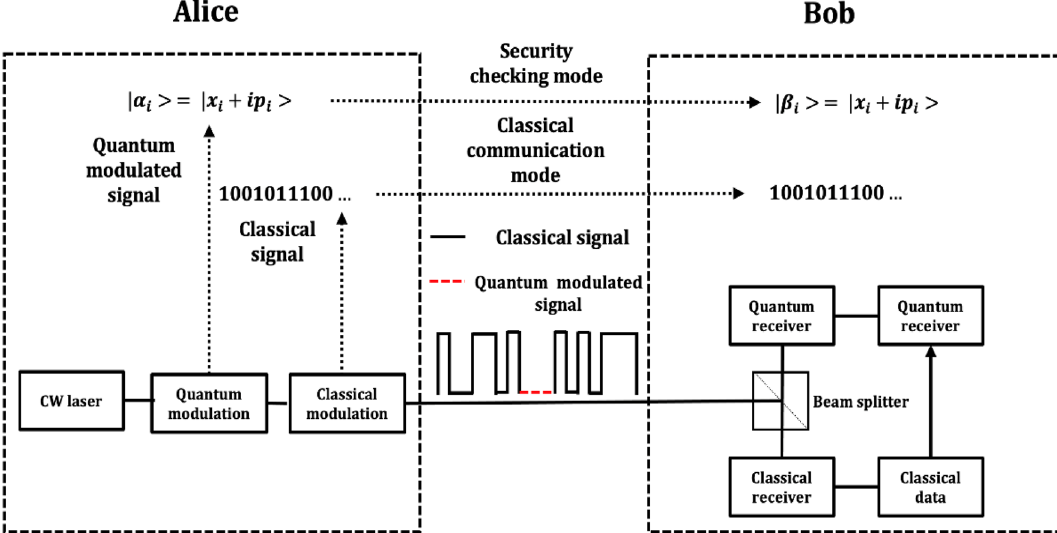
Figure 1. Block diagram of an example quantum alarm system. The transmitter consists of both classical and quantum modulation modules. Alice randomly chooses sending quantum modulated pilot tone signal